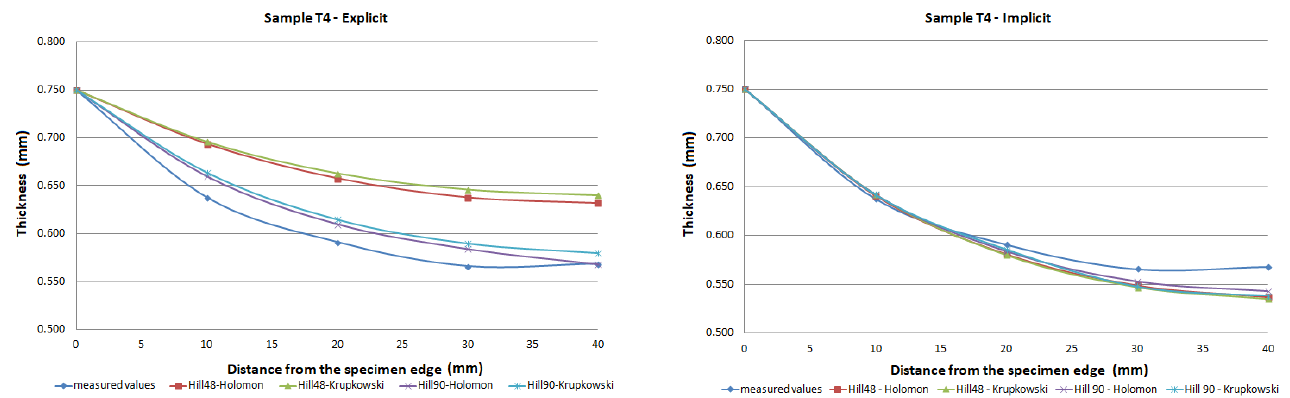
Figure 16. Comparison of predicted and measured thickness values of sample T5 using different types of yield criteria, hardening laws and integration scheme. Figure 17. Comparison of predicted and measured thickness values of sample T6 using different types of yield criteria, hardening laws and integration scheme.